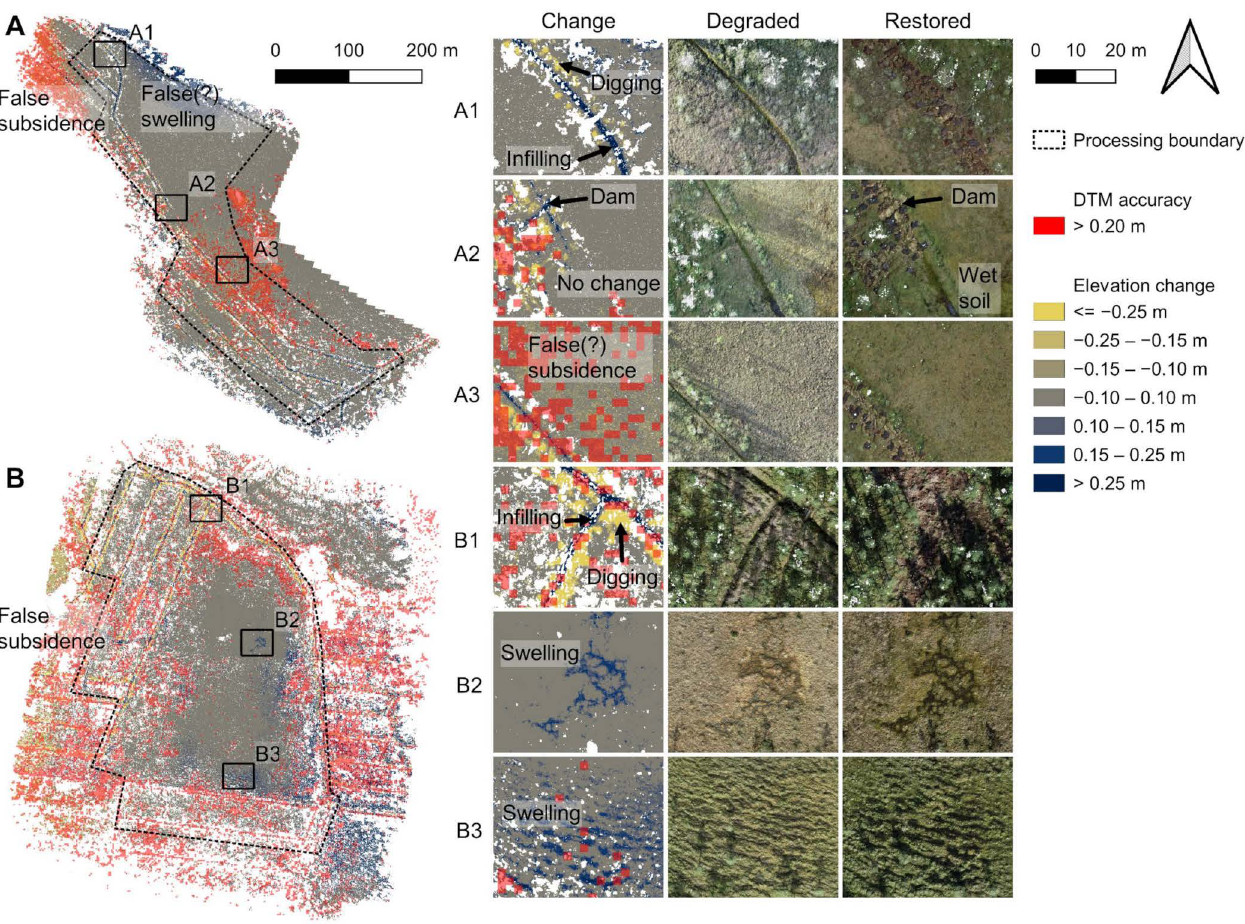
Figure 7. Topographic and visual changes in the restoration of Loukkusuo ( A ) and Iso Leväniemi ( B ) according to the before (IB) and after (IA) SfM datasets. Positive elevation changes correspond to surface rise after restoration. The insets ( A1 – B3) show examples of changed areas in detail and the orthomosaics of the IB and IA campaigns. The topography has been emphasized by overlaying a hillshade Digital Terrain Model (DTM) on top of the orthomosaic picture. Any elevation inspections in the areas of poor accuracy (error > 20 cm according to the reference LiDAR data, coloured as semitransparent red) should be performed with